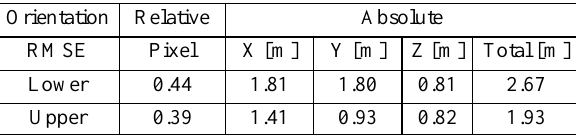
Table 1. Results of relative and absolute orientation of archival